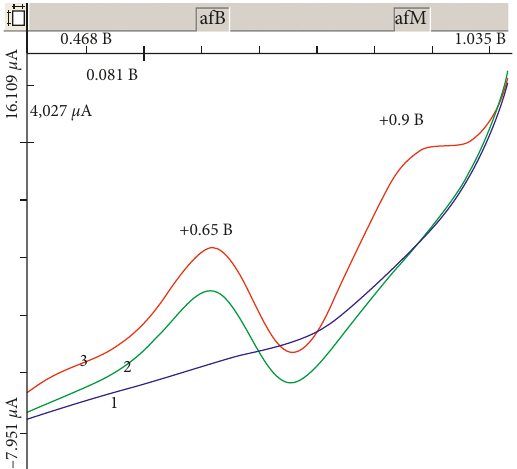
N 1 and 1 electric oxi- 3 mg/dm 3 and 2 10 × 1 (cid:31) 4 mg/dm 3 − afM 1 (cid:31) 2 × 10 −